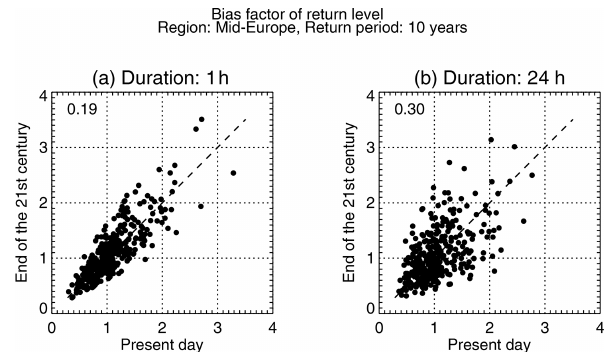
Figure 10. Relationship between bias factors in the present-day and end-21st-century in 10-year return levels for the mid-Europe sub- region for all model/pseudo-observation combinations. (a) The 1h duration and (b) 24h duration, respectively. Numbers in upper left corners are the R indices. See text for